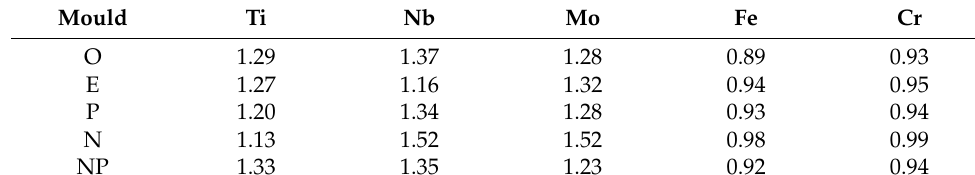
Table 5. Segregation ratio (SR) of alloying elements after heat treatment.